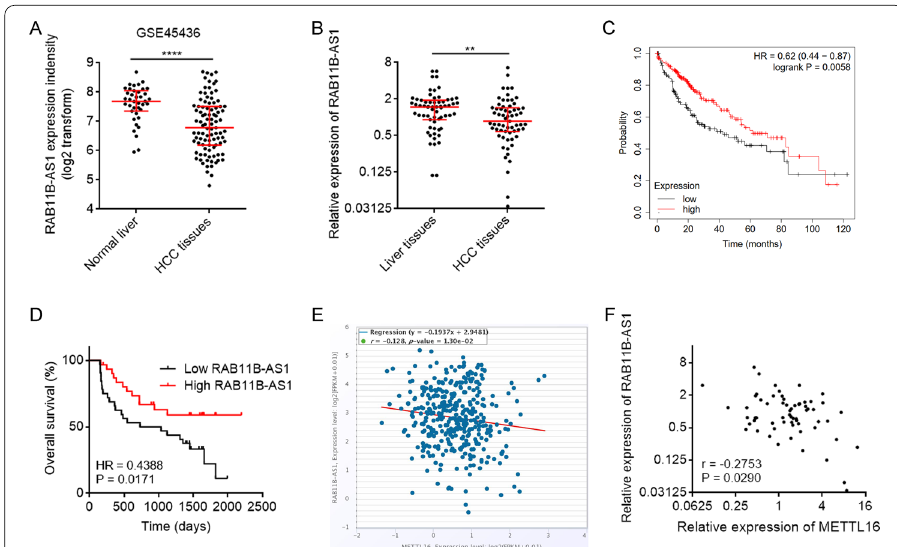
Fig. 5 The expression pattern of RAB11B‑AS1 in HCC and its association with METTL16. A RAB11B‑AS1 expression in human HCC tissues ( n 95) and normal liver tissues ( n 39) from GSE45436 dataset. = = **** P < 0.0001 by Mann–Whitney test. B RAB11B‑AS1 expression level in 63 pairs of HCC tissues and matched adjacent noncancerous liver tissues was measured by RT‑qPCR. ** P < 0.01 by Wilcoxon signed‑rank test. C Kaplan–Meier survival analysis of the correlation between RAB11B‑AS1 expression and overall survival based on TCGA liver cancer data, analyzed by the online in silico tool Kaplan–Meier Plotter (https:// kmplot. com/ analy sis/). D Kaplan–Meier survival analysis of the correlation between RAB11B‑AS1 expression and overall survival in our HCC cohort. n 63 patients with HCC. P 0.0171 by log‑rank test. Median RAB11B‑AS1 = = level was used as cutoff. E The correlation between RAB11B‑AS1 and METTL16 expression in 374 HCC tissues according to TCGA dataset, analyzed by the online in silico tool ENCORI. F The correlation between RAB11B‑AS1 and METTL16 expression in 63 HCC tissues detected by qRT‑PCR. r 0.2753, P 0.029 by = − = Spearman correlation